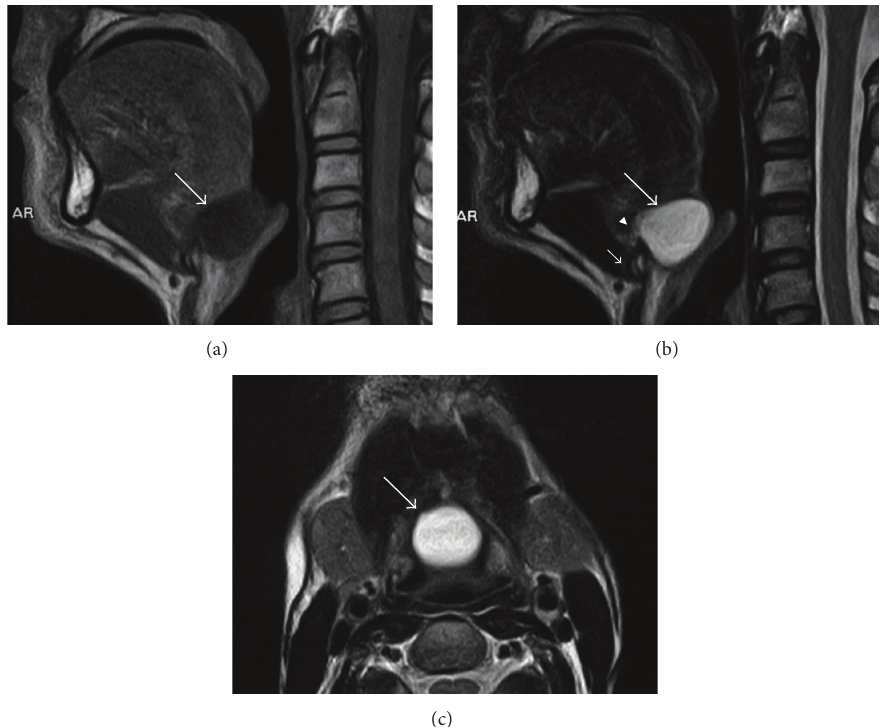
Figure 1: (a) Sagittal T1-weighted (TR/TE, 585/10), (b) sagittal T2-weighted (TR/TE, 4000/100), and (c) axial T2-weighted (TR/TE, 4000/100) MR images of the neck. The round mass (large arrow) has a homogenous low signal intensity in (a) and a high signal intensity in (b) and (c), suggesting a cystic lesion. In (b), there is a black and white striped tract (arrowhead) from the hyoid bone (small arrow) to the mass (large arrow), suggesting the thyroglossal